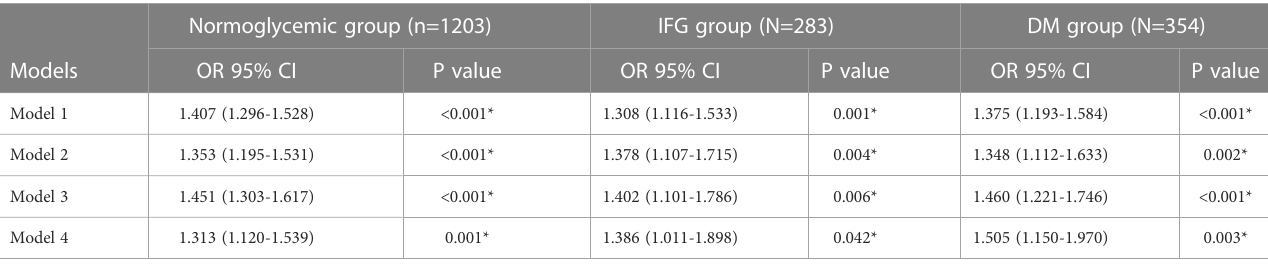
TABLE 2 Association between SUA and AF in different FBG patterns.